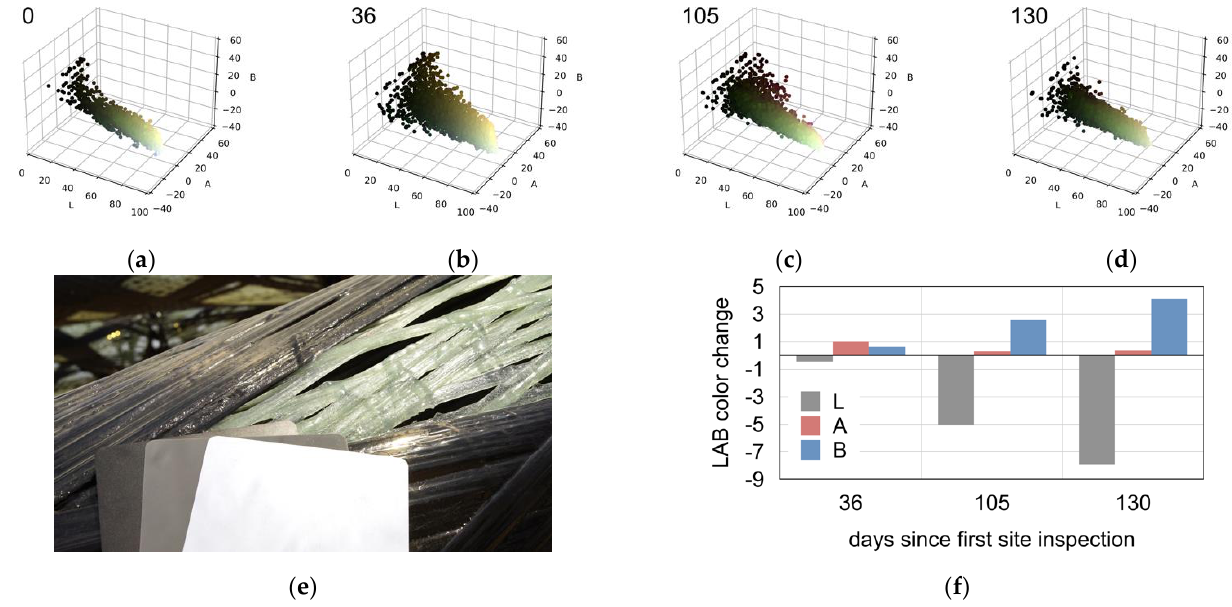
Figure 7. Monitoring results of the composite yellowing: ( a – d ) plots of the pixel colors in LAB color space for inspection, days 0, 36, 105, and 130. ( e ) Example picture with reference cards. ( f ) Relative changes in averages for LAB values (L = 0 to 100 = black to white, A = − 128 to +127 = green to red, B = − 128 to +127 = blue to yellow).